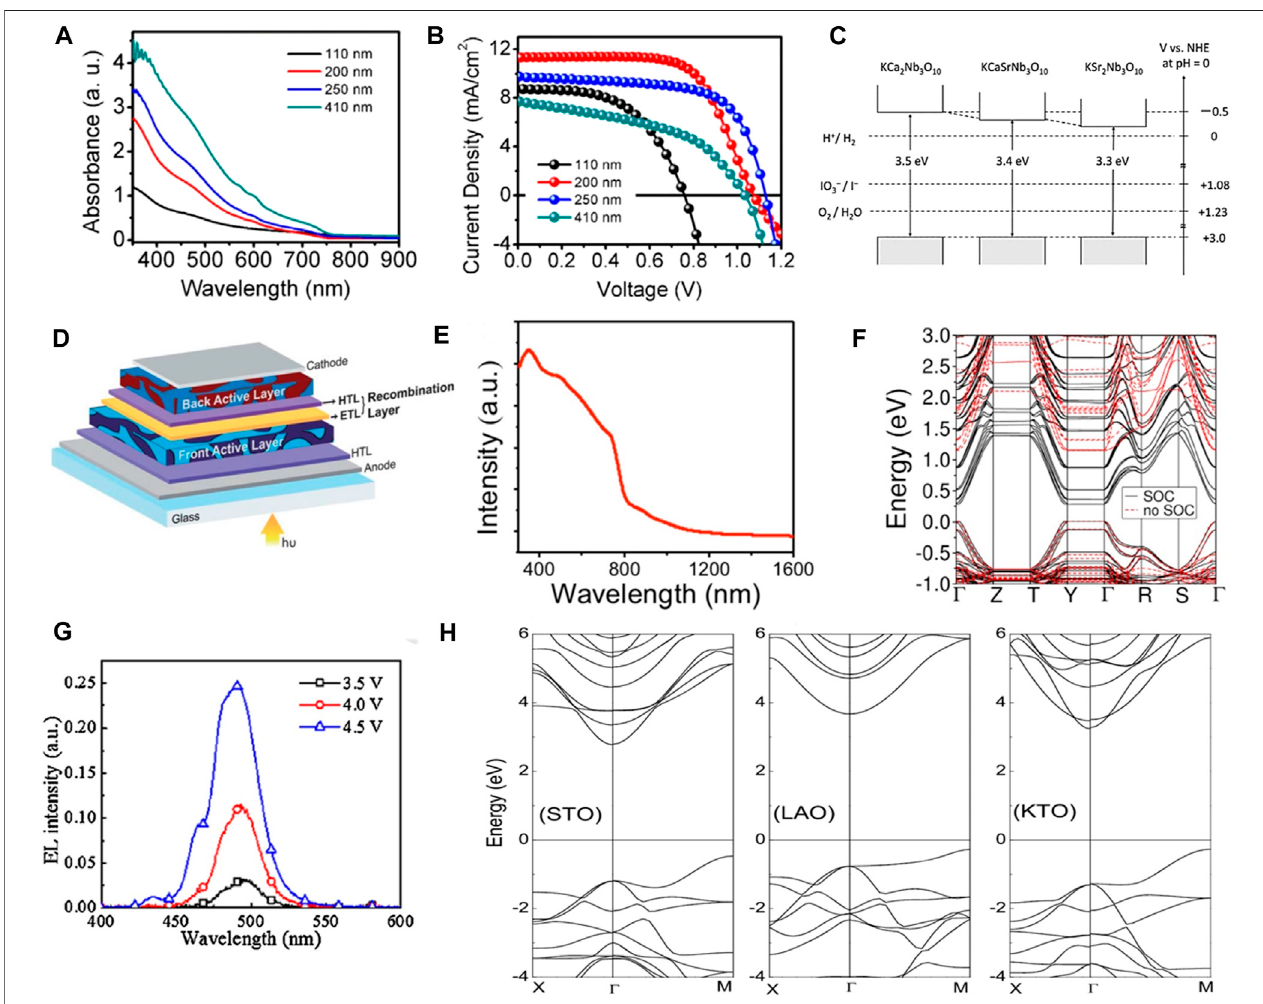
FIGURE 7 | (A) UV-Vis absorption spectra of 2D Pb 5 perovskite fi lms. (B) J-V curves of Pb 5 devices [adapted and modi fi ed from (Liu et al., 2017)]. (C) Schematic illustration of the band structures of restacked KCa 2 Nb 3 O 10 , KCaSrNb 3 O 10 , and KSr 2 Nb 3 O 10 [adapted and modi fi ed from (Oshima et al., 2016]. (D) Device structure of tandem polymer solar cell [adapted and modi fi ed from Chang et al., 2012)]. (E) UV-Vis near-IR absorption spectrum of the 2D CH 3 NH 3 PbI 3 perovskite nanosheets [adapted and modi fi ed from (Li et al., 2017)]. (F) Band structure of BA 2 MA 4 Pb 5 I 16 with and without SOC [adapted and modi fi ed from (Stoumpos et al., 2017)]. (G) Electroluminescent spectra of PCPbB device at different applied voltages [adapted and modi fi ed from Cheng et al., 2017)]. (H) Band structures of STO-ML, LAO-ML, and KTO-ML [adapted and modi fi ed from (Xiao and Liu, 2021)].